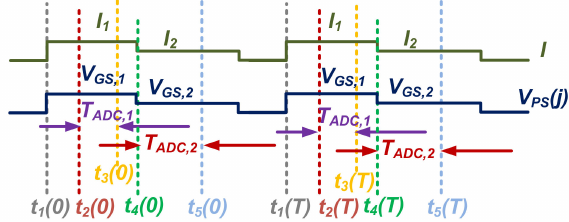
Figure 1. Schematic of four-transistor pinned-photodiode (4T PPD) image pixel based process sensor.